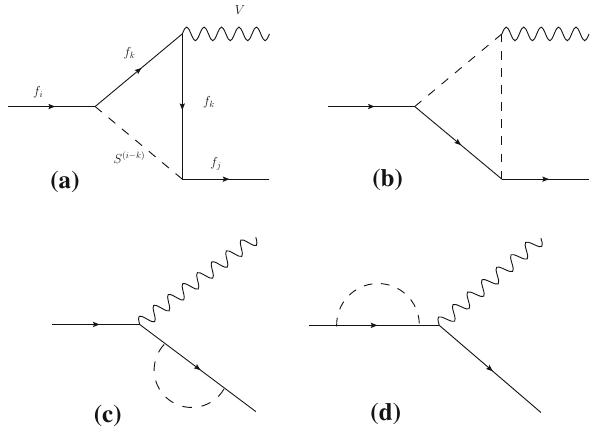
Fig. 2 LQ contribution to the decay f i → f j V ( V = γ, Z ) , where f i and f j are charged leptons (quarks) and f k is a quark (lepton). Here Q i − k is the LQ charge in units of e . Analogue diagrams give rise to the f i → f j H decay with the V gauge boson replaced by the Higgs boson. As far as the q i → q j g decay is concerned, there is only contribution from diagrams b) to d) as the internal fermion is a lepton